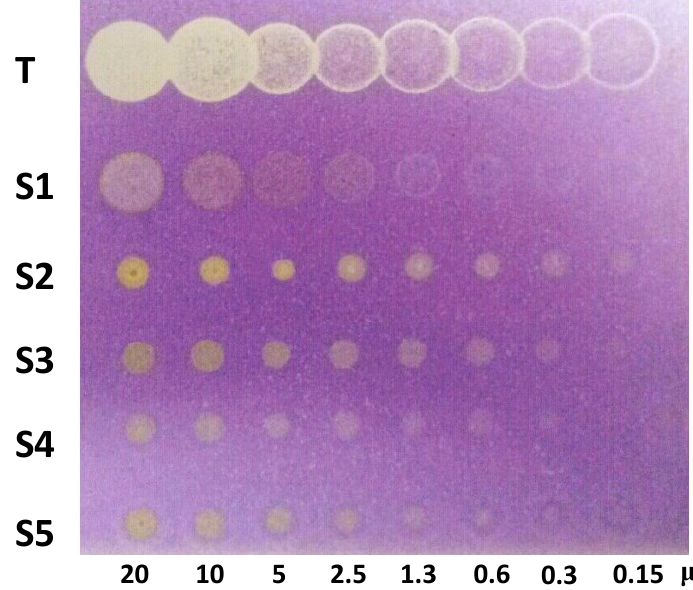
Figure 3. TLC plate showing the antioxidant activity by compounds ( 1 – 5 ) and Trolox (T). Substances along the y-axis and concentration along the